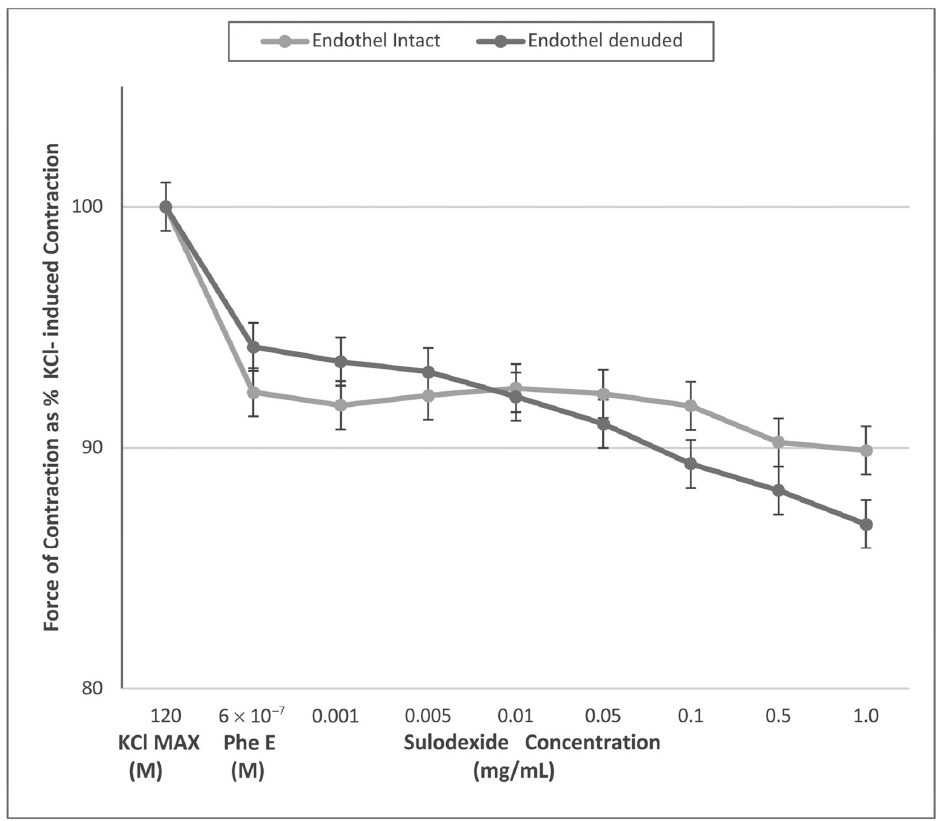
Figure 2. Sulodexide dose-response (0.005 mg/mL − 1 mg/mL) curves of phenylephrine (PheE) pre- contracted endothelium-intact and -denuded venous rings after L NAME (10 − 4 M) pre-incubation. Data presented as the percentage of maximum contraction (KCl MAX) induced by KCl (120 mM).